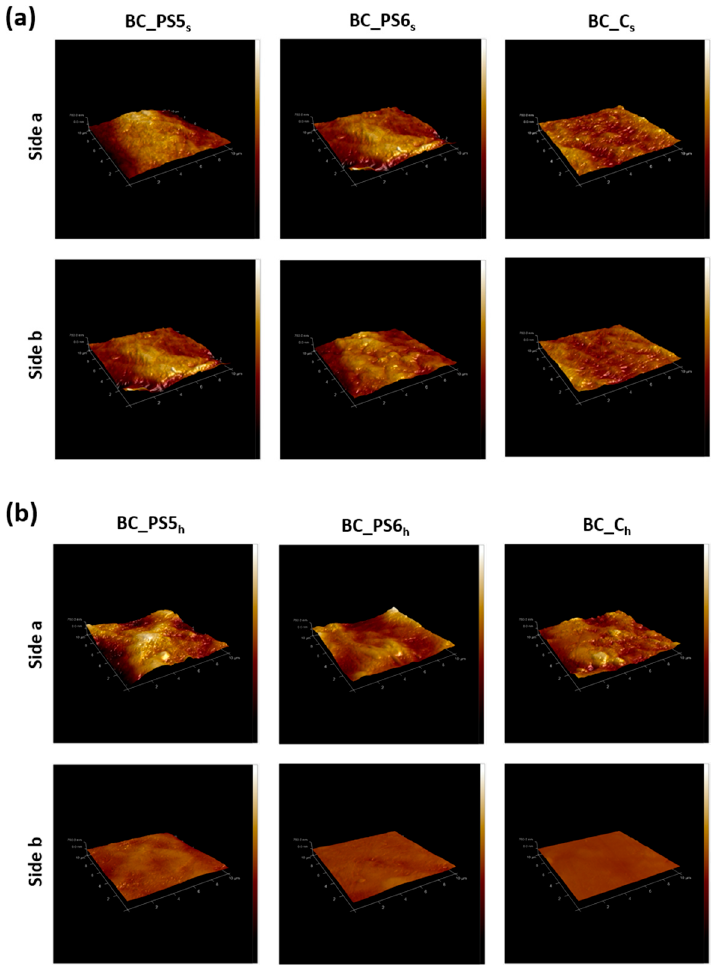
Figure 4. AFM images of samples. ( a ) Samples obtained from non-homogenized BC. ( b ) Samples obtained from homogenized BC. Size of the images: 10 µm × 10 µm × 750 nm.